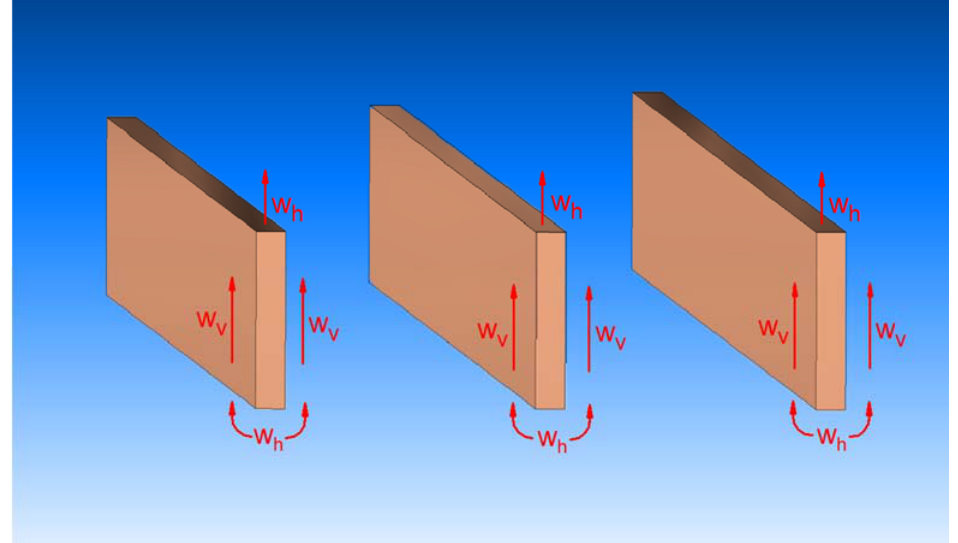
Figure 2. A scheme of heat dissipation in the switchgear. Analytical determination of the amount of thermal energy transferred by convection is a difficult issue due to the large number of variables and the complexity of initial and boundary conditions. The coefficient values can be determined experimentally, with the proviso that the results obtained are valid only for the conditions occurring during the measurement. In the field of thermokinetics of electrical apparatuses, similarity theory is used to quantify the value of heat transfer that is causing hotter air to lift. face area of the conductor ( (cid:1865) (cid:2870) ).